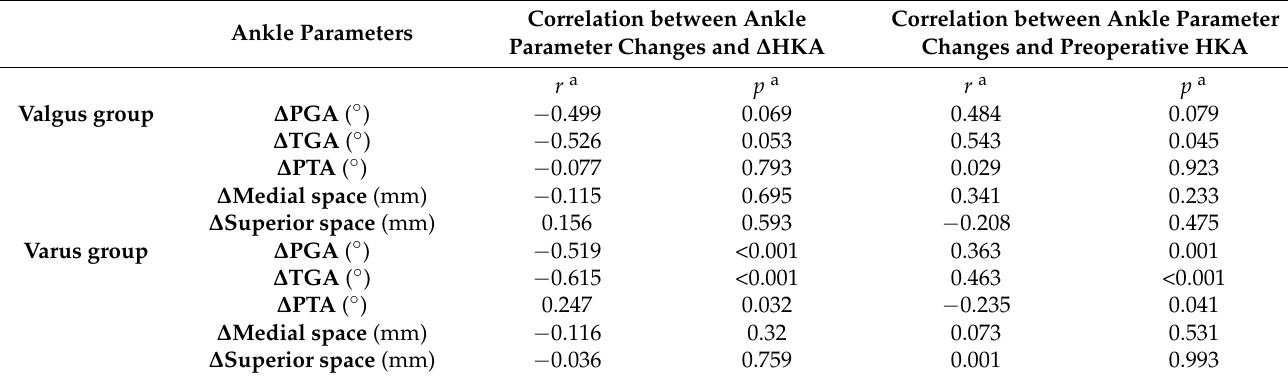
Table 3. Correlation between ankle parameter changes and HKA changes as well as preoperative HKA.